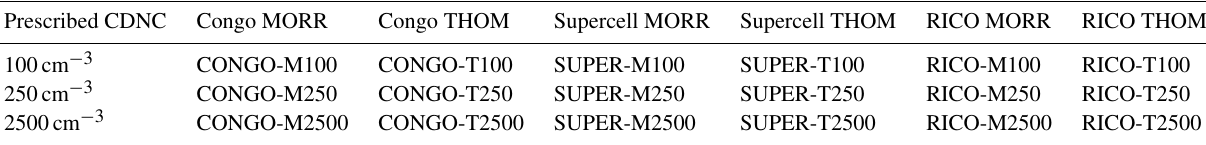
Table 2. List of microphysics configurations tested and the abbreviations used for each run. Prescribed CDNC Congo MORR Congo THOM Supercell MORR Supercell THOM 100cm −